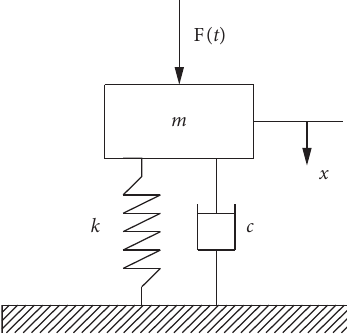
Figure 10: Mechanical model of combined isolation